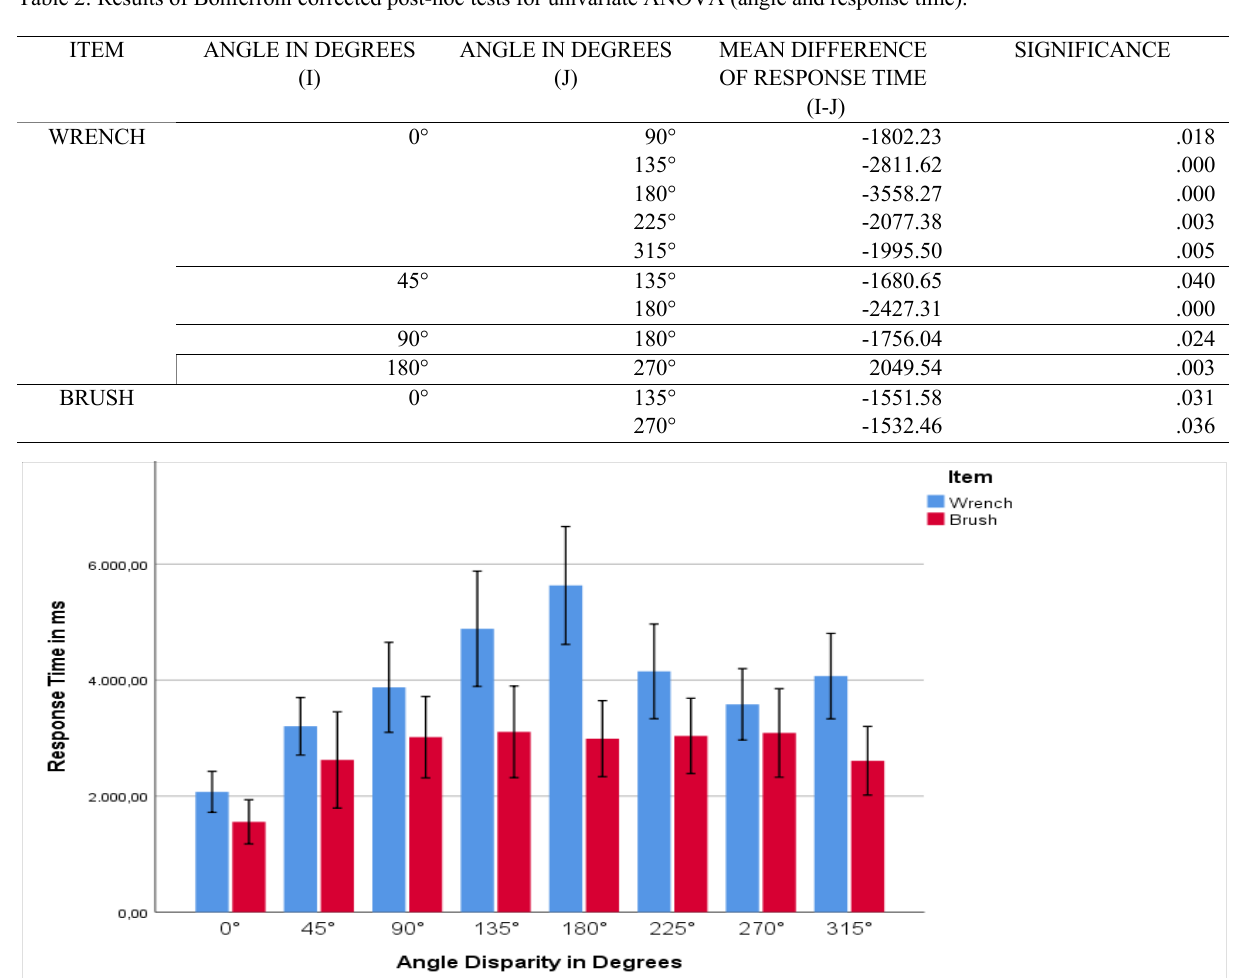
Figure 10: The average response time of the subjects per angle for the items wrench and